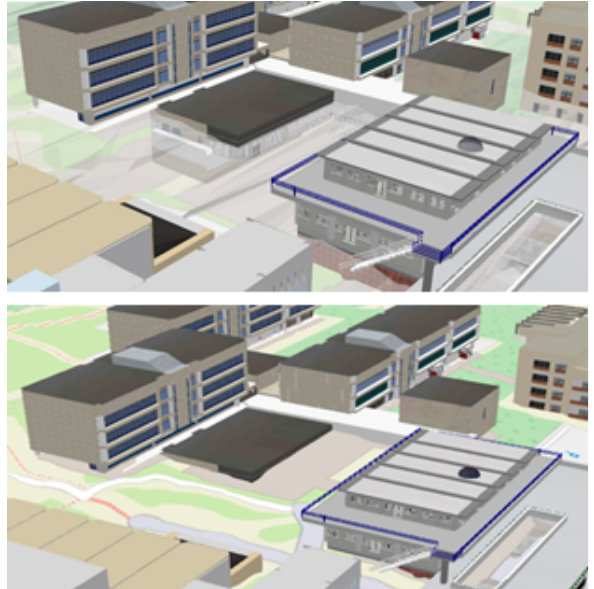
Figure 6. Visualisation of underground structures using the elevation service (top). Without the use of the elevation service underground facilities are not visible